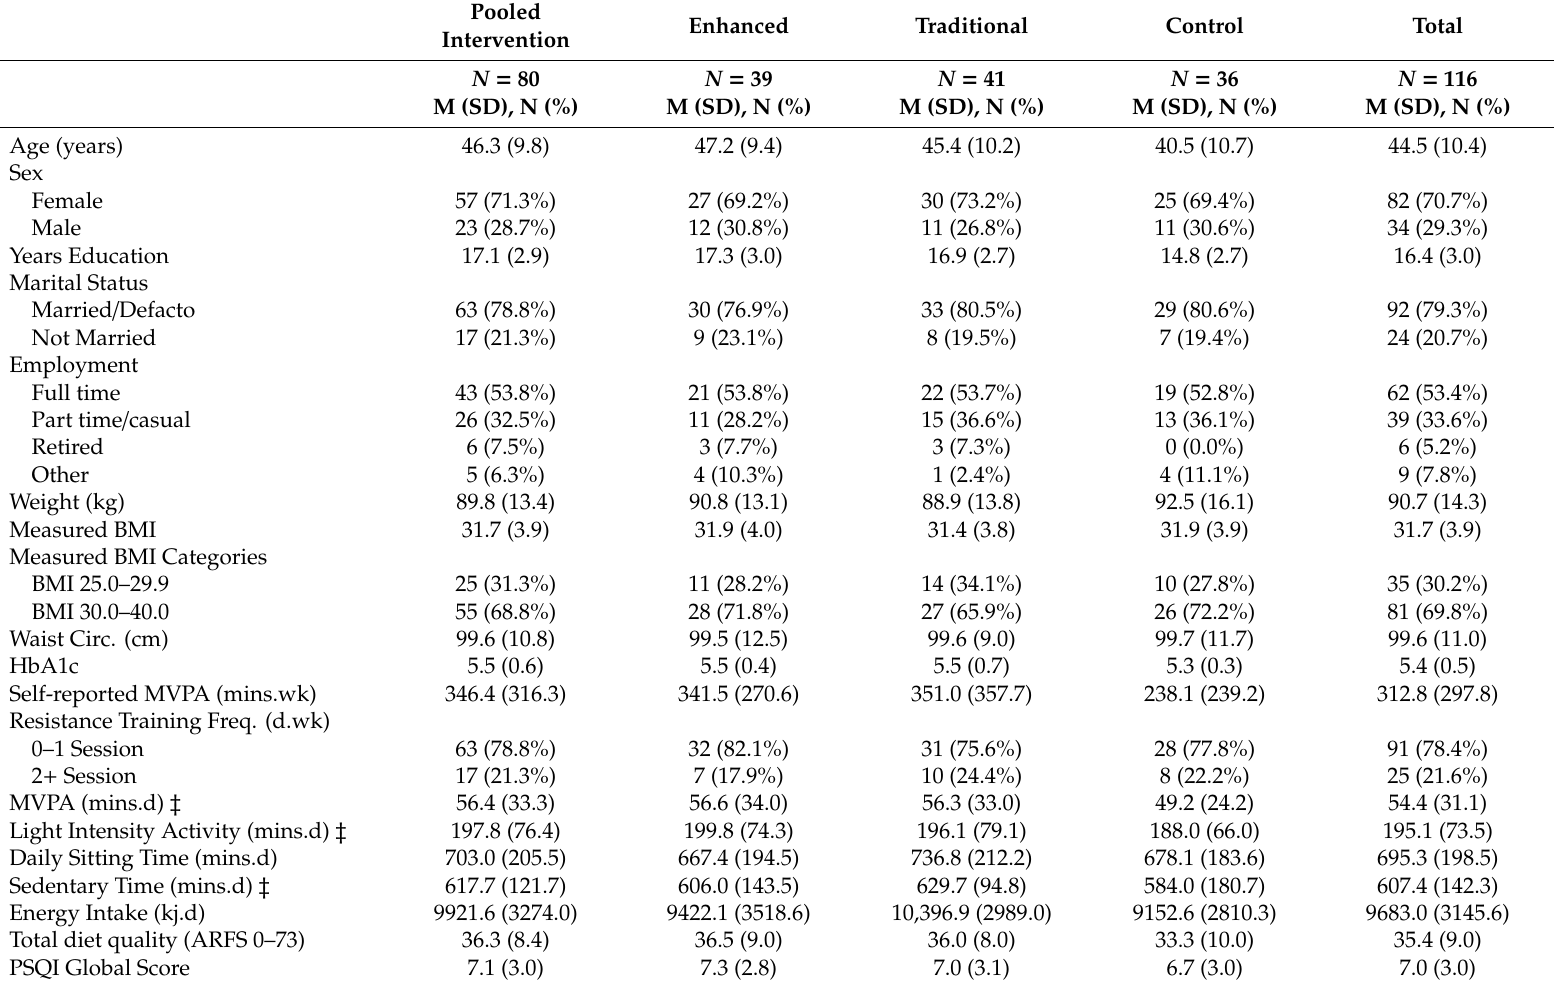
Table 1. Baseline sociodemographic, health and behavioural characteristics of participants by group. Pooled Intervention